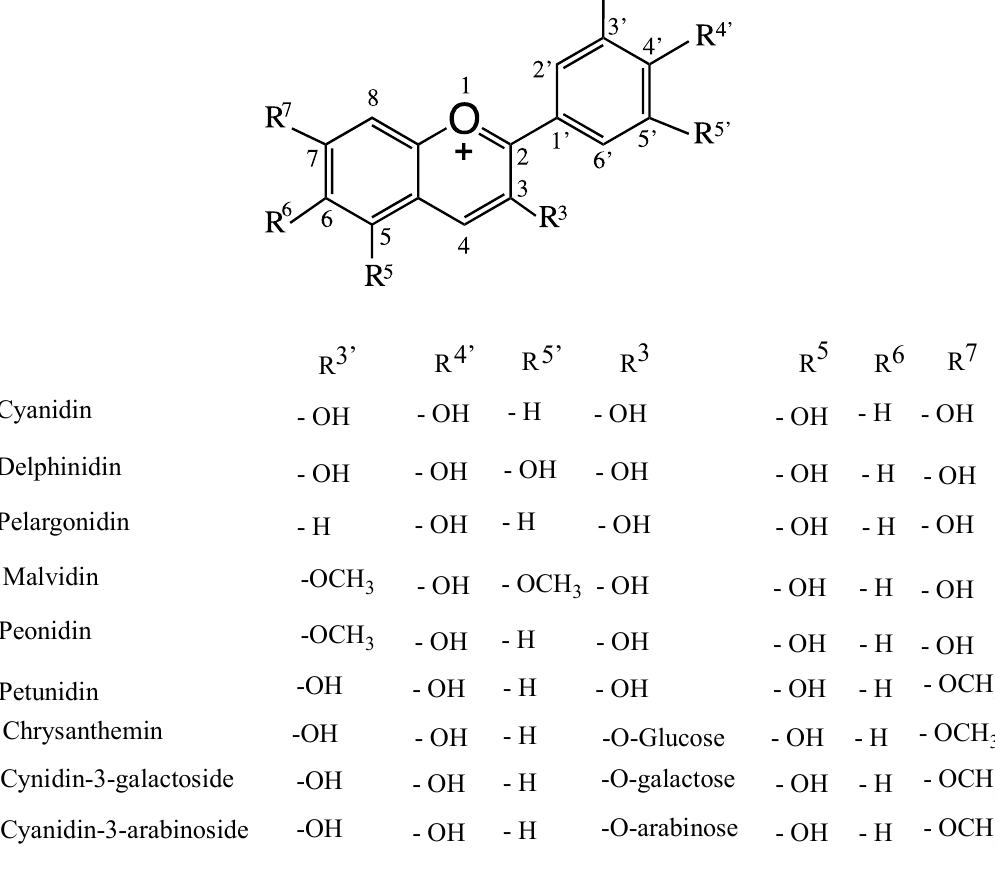
Figure 1. Naturally occurring substituted cyanidins and anthocyanidins.